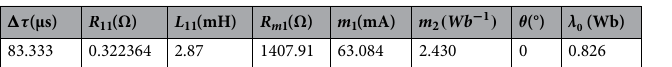
Table 7. Transformer Inrush